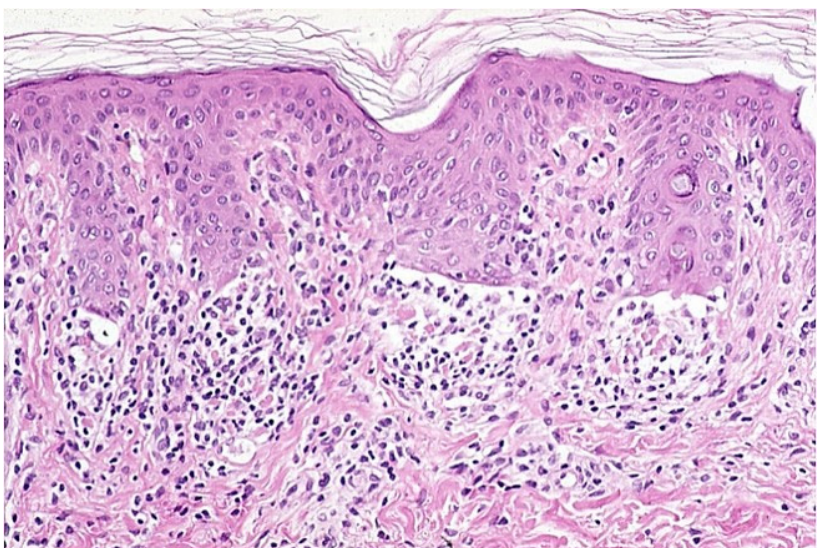
Figure 5. There is a dense lichenoid infiltrate of lymphocytes limited to the tips of rete ridges, which acquire a quadrangular shape as a consequence of massive necrosis/apoptosis of keratinocytes. Note that the epidermal supra-papillary plates are spared by the inflammatory infiltrate.